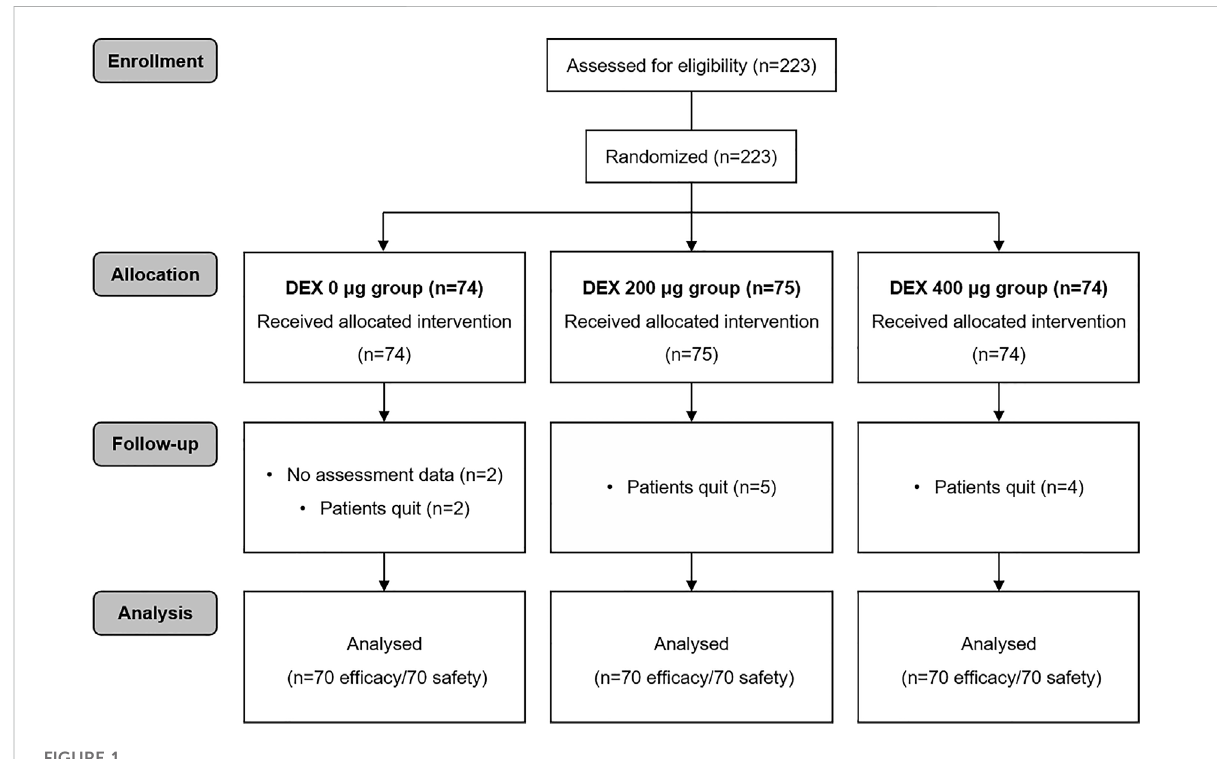
FIGURE 1 CONSORT diagram. DEX,